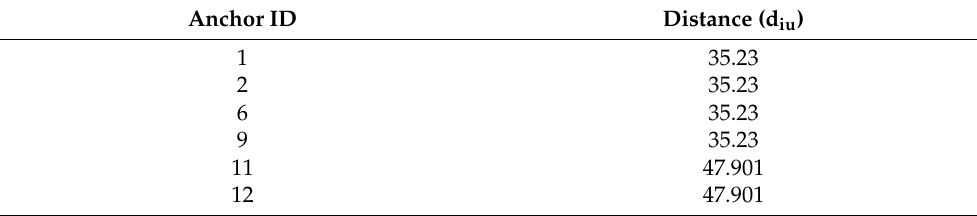
Table 5. Distance of node “ N ” from each anchor for specific threshold